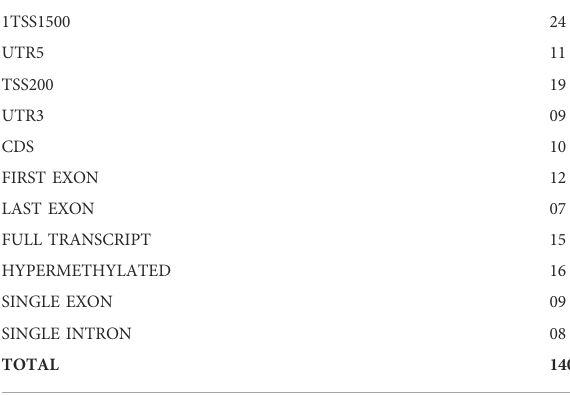
TABLE 2 List of best features that help to obtain best AUC and